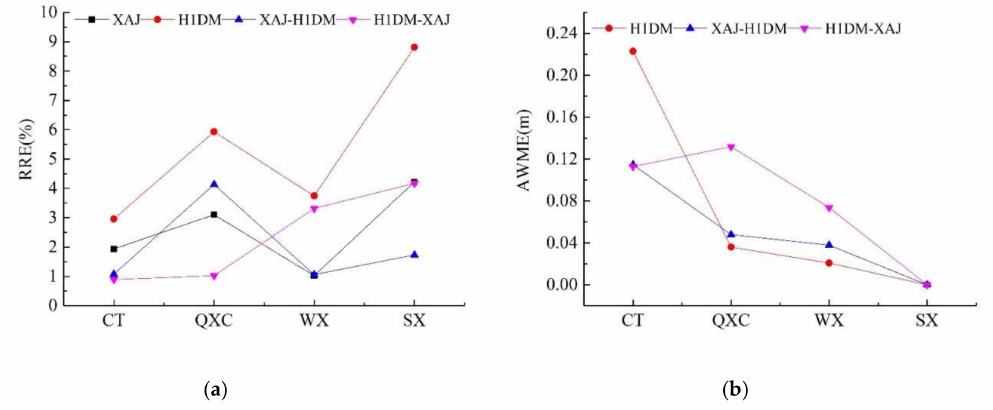
Figure 8. Average RRE ( a ) and AWME ( b ) of the four sites for all